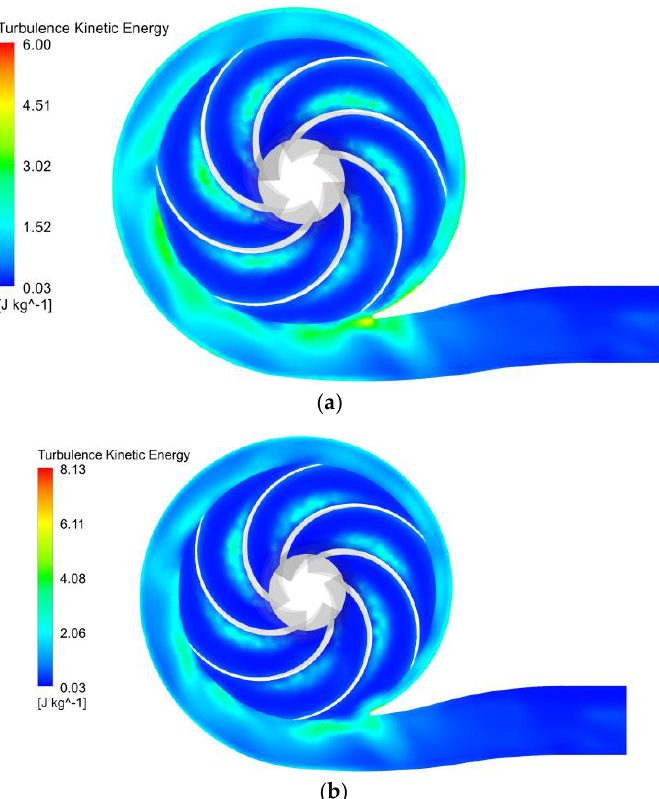
Figure 30. Turbulence kinematic energy contour distribution on the middle section of the discharge chamber under Q 0.6 : ( a ) Impeller phase at 0°; ( b ) Impeller phase at 30°.